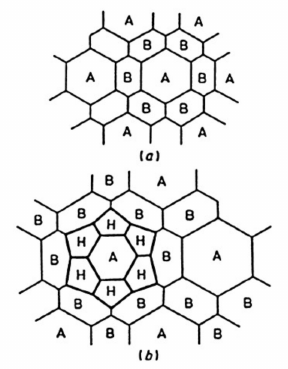
Figure 45. Regrouping of Wigner–Zeitz Voronoi polyhedra due to H absorption. ( a ) before hydrogen absorption and ( b ) after hydrogen absorption. Adopted from [140], with permission from IOP Publishing,